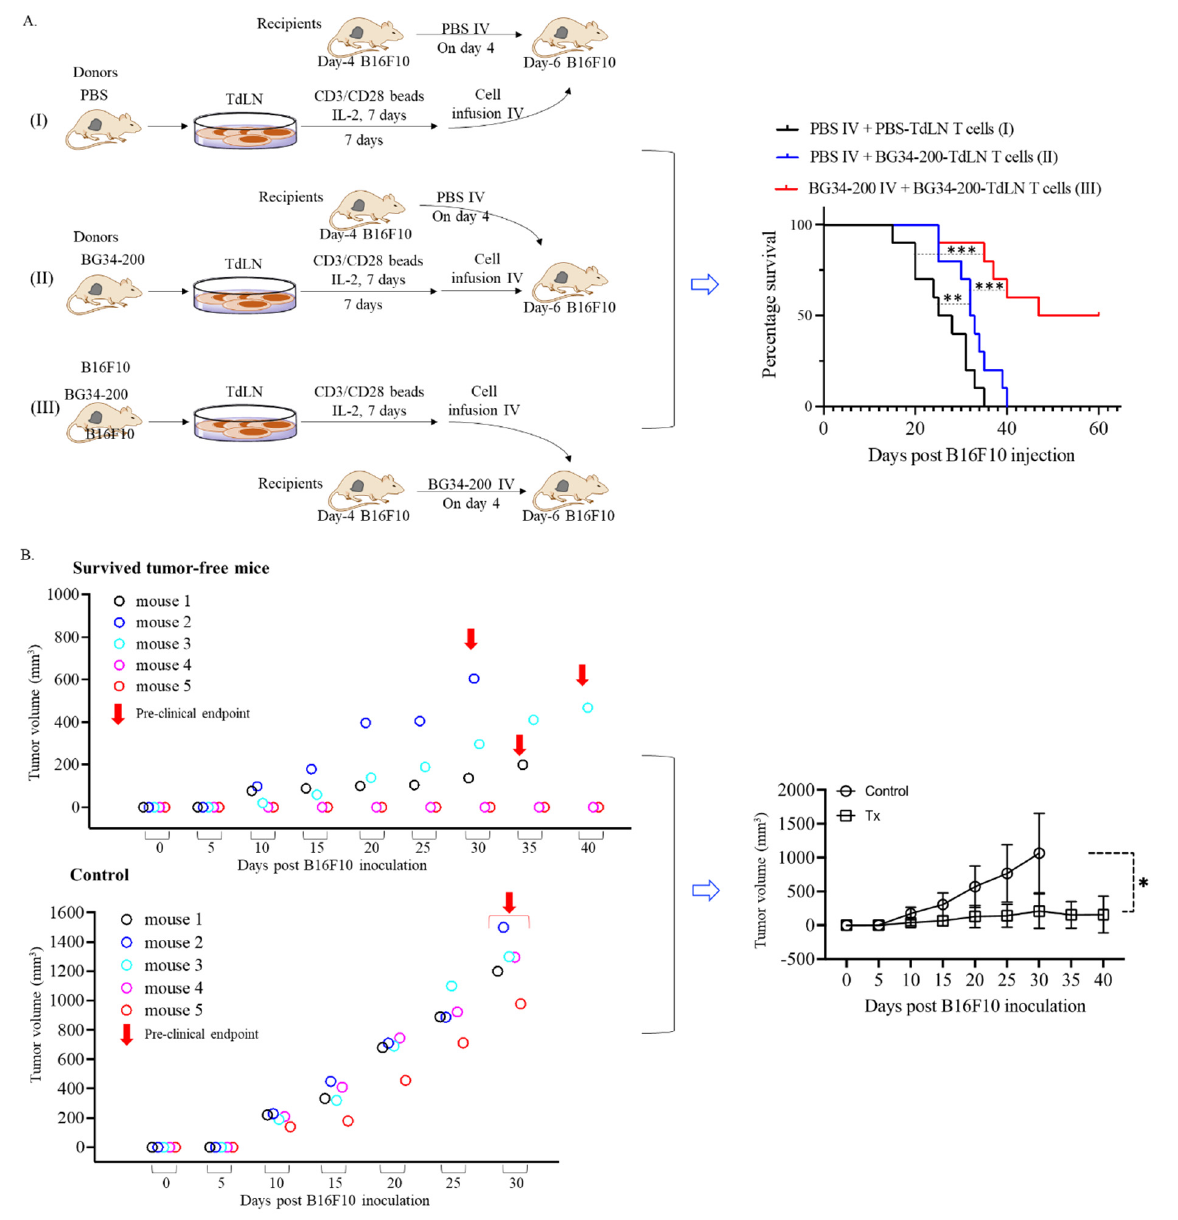
Figure 6. TdLN-derived T cells from BG34-200-treated donor B16F10 mice induce significantly improved antitumor effect in recipient mice bearing advanced B16F10 tumors. ( A ). Kaplan – Meier overall survival curves of recipient mice in group I, II and III. The TdLNs were harvested from donor B16F10 mice receiving a PBS (group I) or BG34-200 (group II and III) intravenous injection, cultured/expanded using T-cell activation beads (CD3/CD28) in the presence of recombinant IL2 cytokines, and adoptively transferred to recipient mice. For the donor mice, one million B16F10 cells were injected into left flanks on day 0; PBS (group I) or BG34-200 (groups II and III) were intravenously administrated on day 4. For the recipient mice, 1.5 million B16F10 cells were injected into left flanks on day 0; PBS (group I and II) or BG34-200 (group III) were intravenously administrated on day 4; adoptive transfer of T cells was conducted on day 6. ( B ) . Tumor volume of surviving mice after a second inoculation of B16F10 cells. The surviving mice referred to the five tumor-free mice in group III and received a second tumor cell inoculation. Five naïve tumor-free mice served as control. All the mice were inoculated with 0.25 million tumor cells into the right flank and tumor growth was monitored. n = 5. For A and B, *, p < 0.05; **, p < 0.01; ***, p < 0.001.